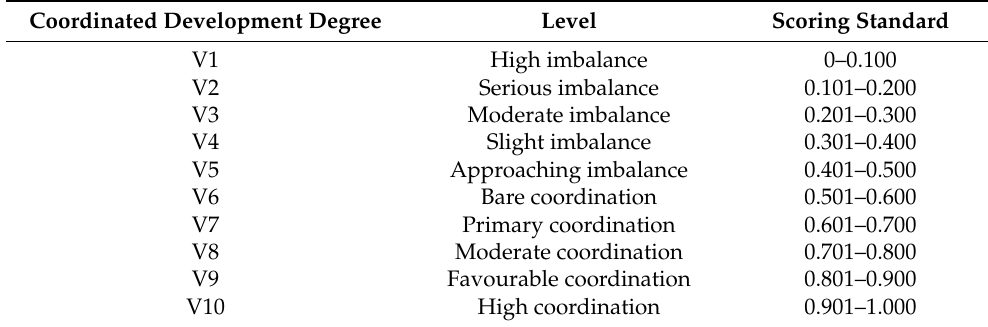
Table 5. Level classification criteria for the coordinated development of sentiment value to medical facility coverage ratio.